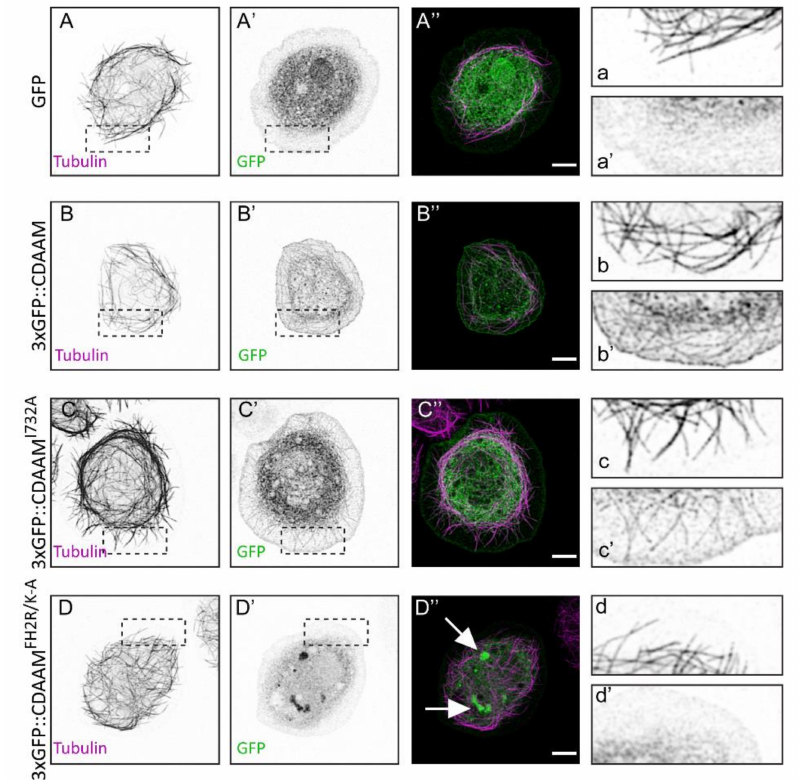
Figure 4. Morphological analysis of S2 cells expressing GFP-tagged wild-type and mutant forms of CDAAM. ( A – D (cid:48)(cid:48) ) Representative images of the cytoskeletal organization of control ( A – A (cid:48)(cid:48) , a , a (cid:48) ), CDAAM ( B – B (cid:48)(cid:48) , b , b (cid:48) ), CDAAMI732A ( C – C (cid:48)(cid:48) , c , c (cid:48) ) and CDAAMFH2R/K-A ( D – D (cid:48)(cid:48) , d , d (cid:48) ) expressing S2 cells. GFP or GFP-tagged CDAAM was detected by an anti-GFP antibody (green), and microtubules are visualized by an anti-tubulin antibody (magenta). Filamentous organization of CDAAM was visible in the cortical lamellipodial region of CDAAM and CDAAMI732A expressing cells (see the insets in b , b (cid:48) , c , c (cid:48) , respectively), which is not present in control cells ( a , a (cid:48) ), and in cells expressing CDAAMFH2R/K-A ( d , d (cid:48) ) where most of the GFP signal accumulates into cytoplasmic foci (arrows in D (cid:48)(cid:48) ). Scale bar represents 5 µ